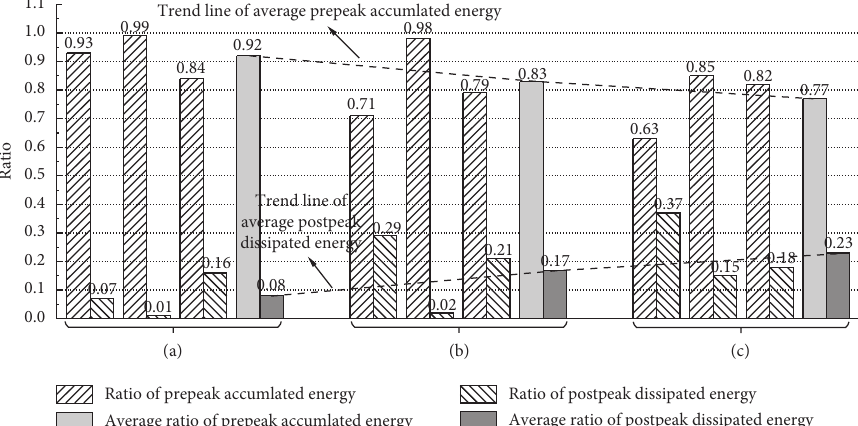
E and gas pressure.